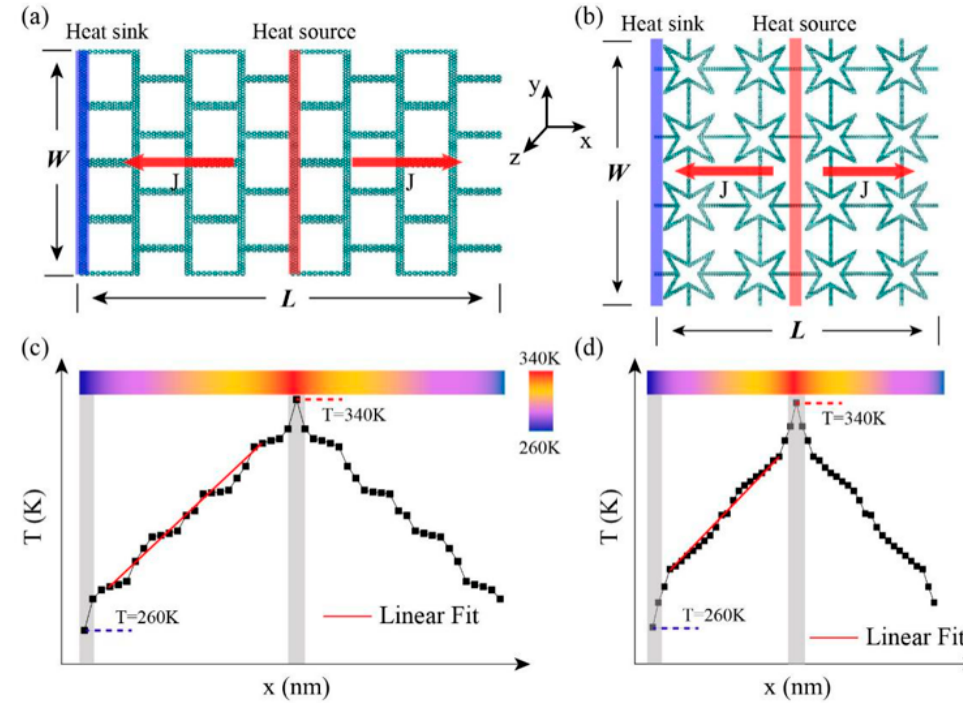
Figure 2. Schematic plot of the reverse non-equilibrium molecular dynamics method in calculating thermal conductivity of ( a ) SKG, and ( b ) QSS model. The average temperature distribution of SKG and QSS model are shown in ( c , d ).